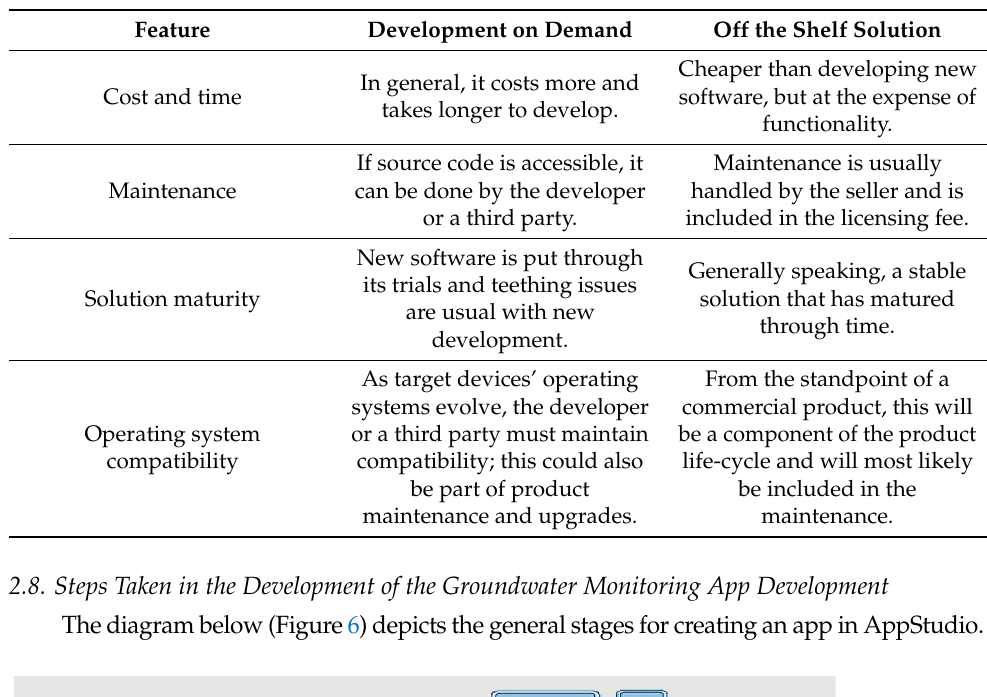
Table 1. Comparison of custom software development vs. off-the shelf solution.